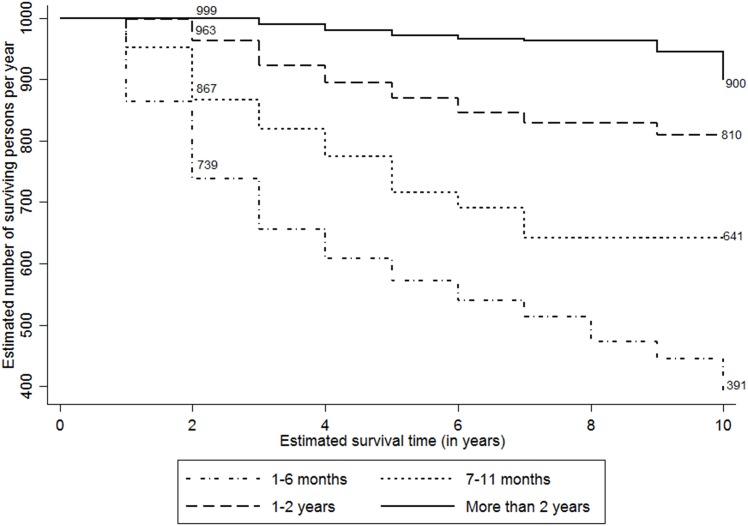
Adjusted Kaplan-Meier survival estimates by duration of programme exposure (per 1000 persons per year).The line graph presents the adjusted survival probability curves among PLHIV per 1000 persons per year since they tested positive for HIV by duration of programme exposure. The estimates are adjusted by the place of residence of PLHIV. The duration of exposure to programme is divided into four categories, i.e. 1 to 6 months, 7 to 11 months, 1–2 years and more than 2 years.